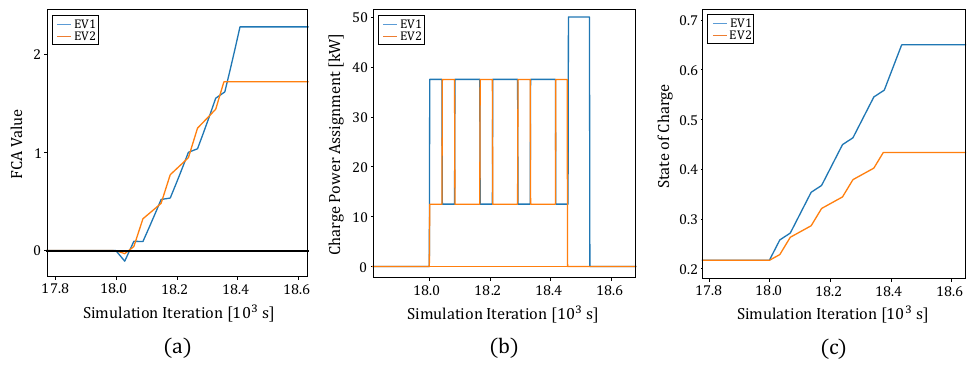
Figure 9. Classic Use Case. ( a ) Feeding Compensation Account, ( b ) Charge Power and ( c ) State of